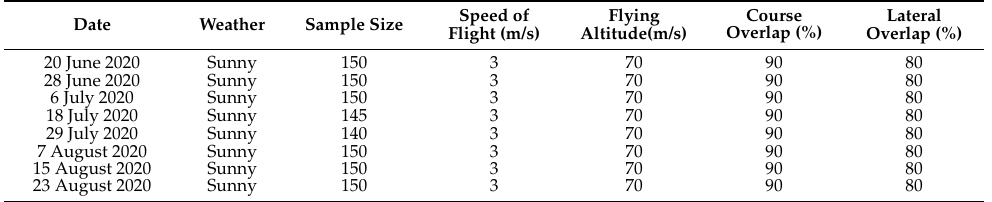
Table 3. Ambient conditions and relevant parameters of the UAV remote-sensing data